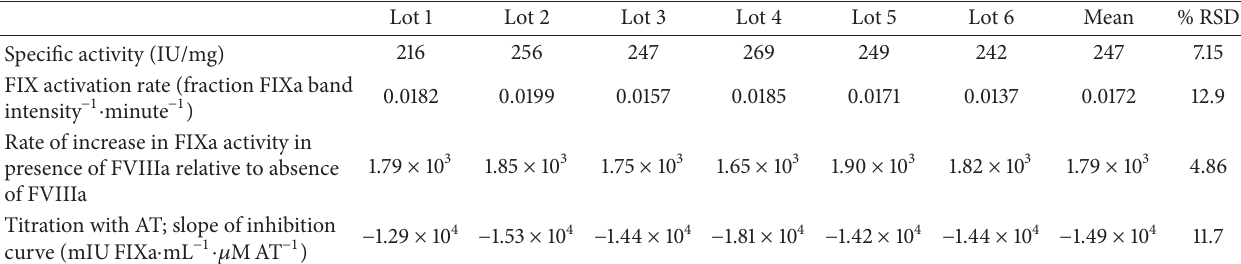
Table 2: Functional characterization of trenonacog